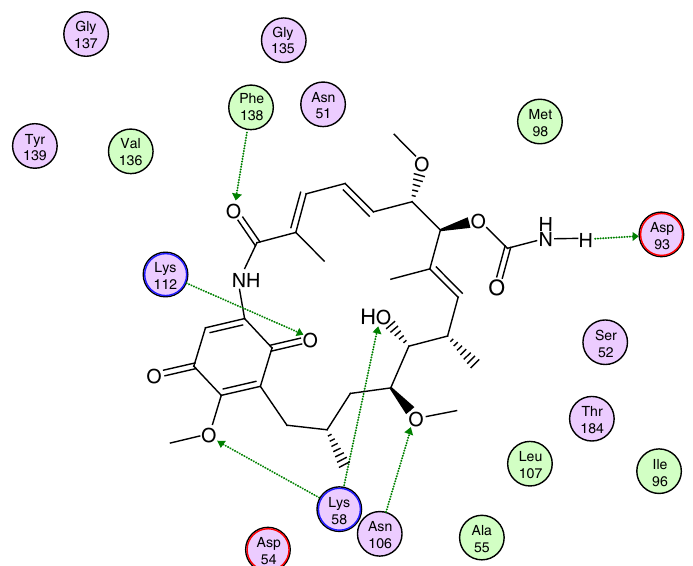
Figure 8. Possible interactions between residues of the active site of Hsp90 and geldanamycin. Green lines indicate the residues donator of hydrogen bridge.